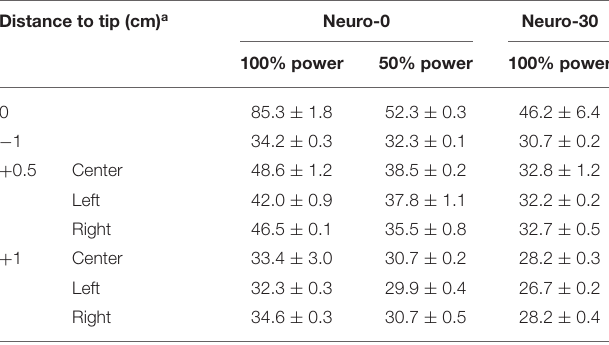
TABLE 2 | Thermal spread with distance in front of or behind the tip and with the LED light source. Distance to tip (cm)